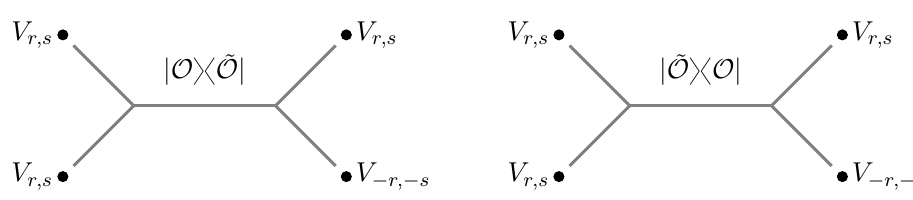
Figure 9 . Potential exchange for an operator O or its reflection ˜ O violating fusion. A pair of distinct three-point functions must be non-vanishing simultaneously if the operator is to contribute to the four-point